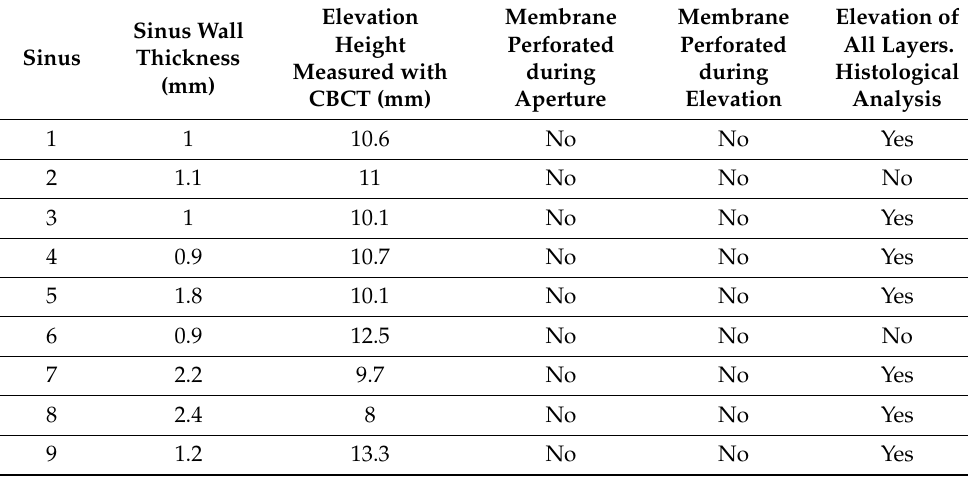
Table 1. Study of sinus wall thickness and heights achieved measured with CBCT.